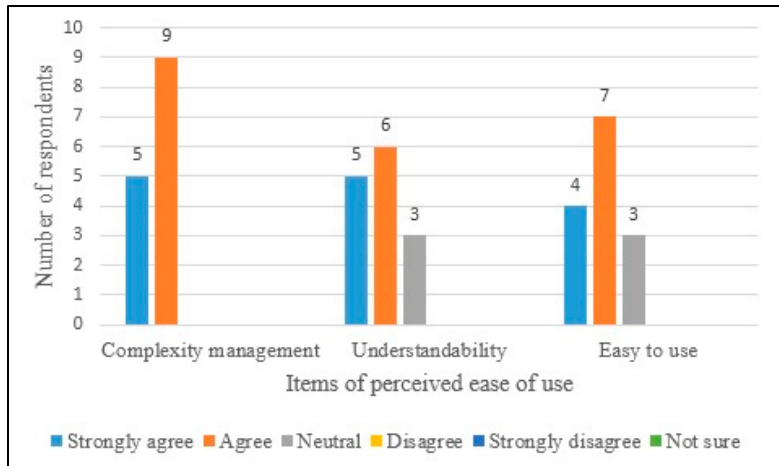
Figure 14. Distribution of responses given to questions on perceived ease of use. Table 6. Analysis results on perceived ease of use.